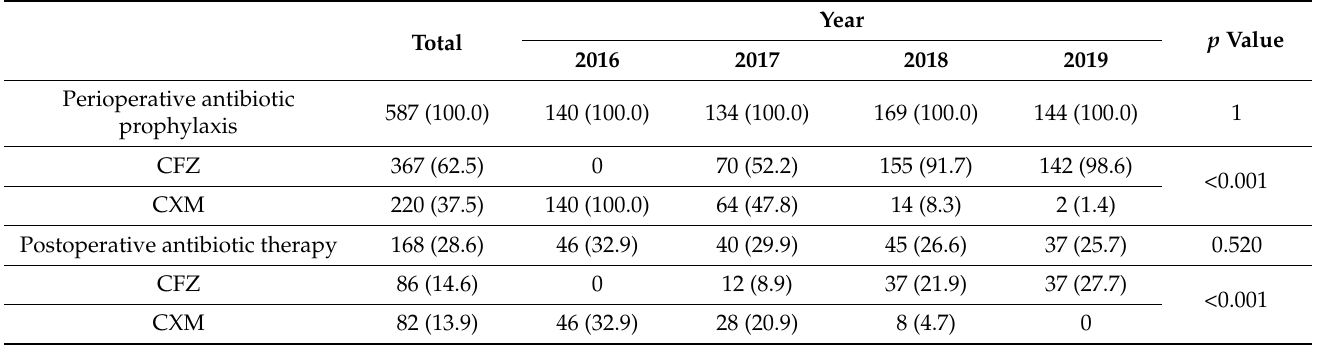
Table 1. Change of perioperative antibiotic prophylaxis from cefuroxime to cefazolin during